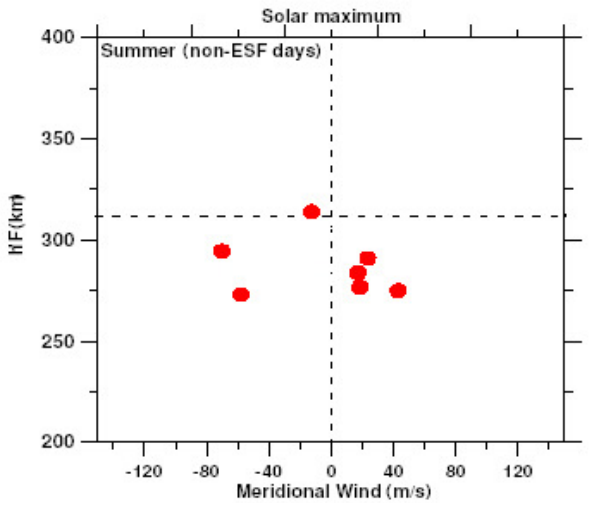
Fig. 1b. Scatter plot of meridional wind and h 0 F at 19:00h on non- ESF days for summer solstice of solar